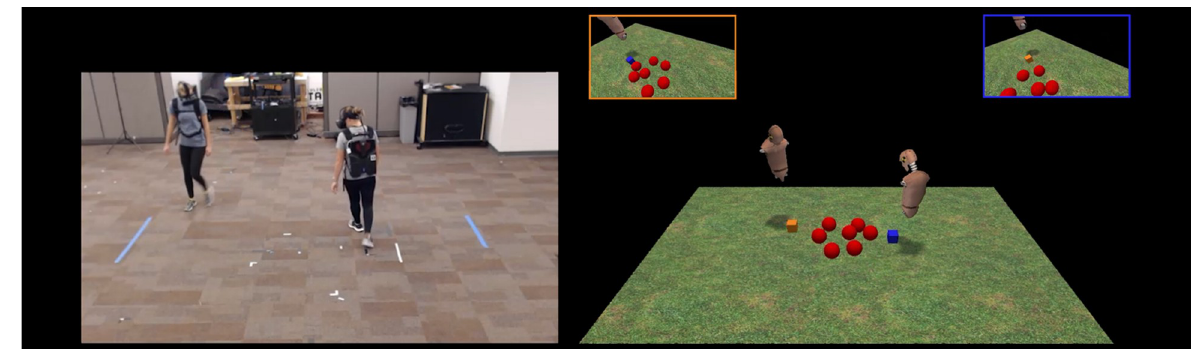
Fig 3. Depiction of experimental setup and task environment. Participants (left) wore virtual reality headsets connected to a computer worn as a backpack. Participants embodied floating avatars (right) and could locomote about a large (6 × 3.48 m) environment to corral and contain seven evasive target agents (TAs; red spheres) within 0.72 m of the TA herd’s mean position. Task difficulty was manipulated by clamping the maximal speed of the TAs’ movements ( � 0.12 m � s -1 , � 0.20 m � s -1 , � 0.28 m � s -1 ). The TAs were reactive to the orange-/blue-colored cubes at the base of each participant’s avatar, which was controlled via their head movements. The orange- and blue-bordered images show the participants’ respective perspectives in their virtual reality headsets. See S1–S3 Videos .